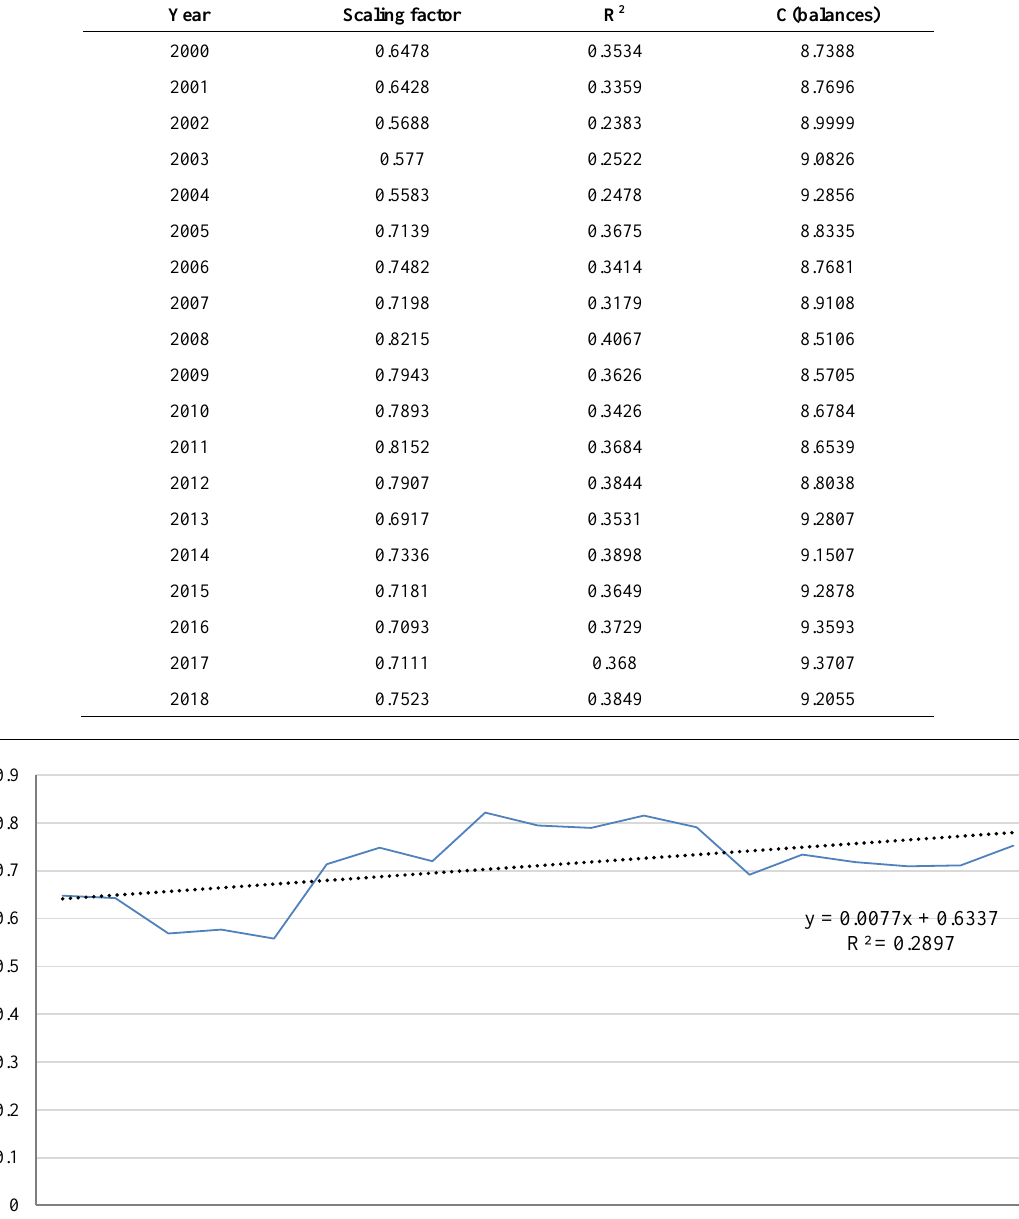
Table 4. Scaling factor ranges for logarithms of GRP per capita and budget expenditures per capita